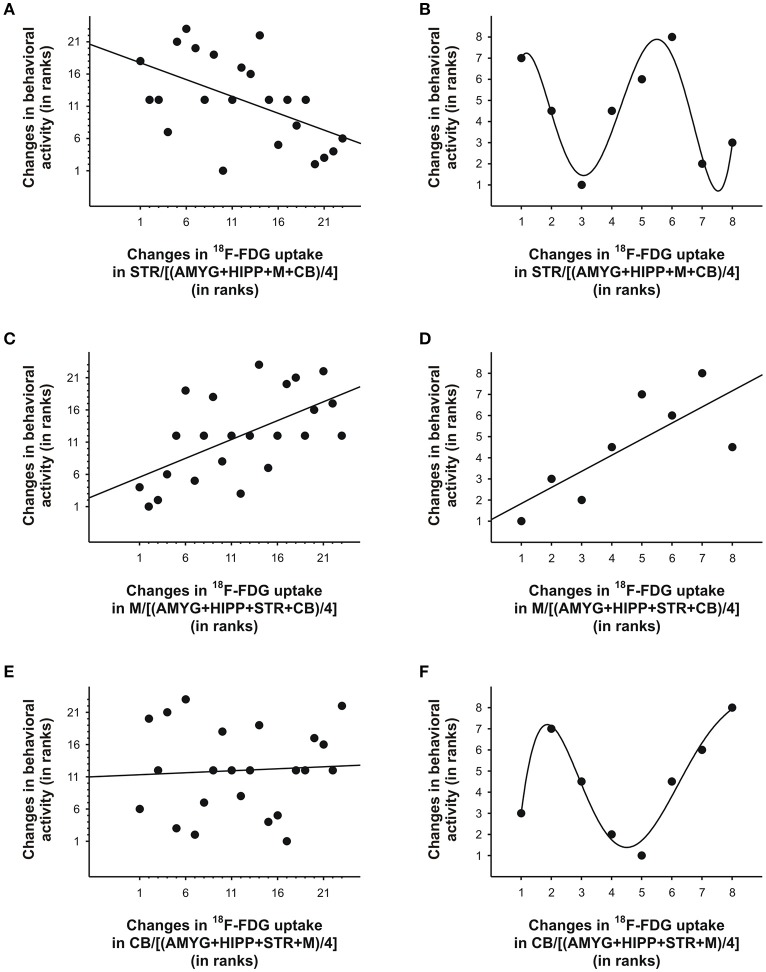
Changes in 18F-FDG uptake correlated with changes in behavioral activity across scan 2 in rat. We correlated changes in 18F-FDG uptake, i.e., differences between successive 5min time bins, in the (A, B) striatum (STR), (C, D)motor cortex (M), and (E, F) cerebellum (CB) relative to a reference region (the average uptake in a combination of four ROIs) with changes in behavioral activity for the same time frames. When all 5min time frames (n = 23) were included for analysis (A, C, E), changes in 18F-FDG uptake in the STR andM, but not CB, significantly predicted changes in behavioral activity across time. When only the time frames (n = 7-8) near the 18F-FDG injections (B, D, F) were included for analyses, a linear function could be used to predict changes in behavioral activity from changes in uptake inM (D), but polynomial functions provided the best fit for the data from STR (B) and CB (F). For illustration, we fitted a quintic polynomial to the data (B, F). The data are represented as ranks. Rank 1 indicates the largest decrease, whereas the highest rank indicates the largest increase between any of two successive 5-min-long time frames.